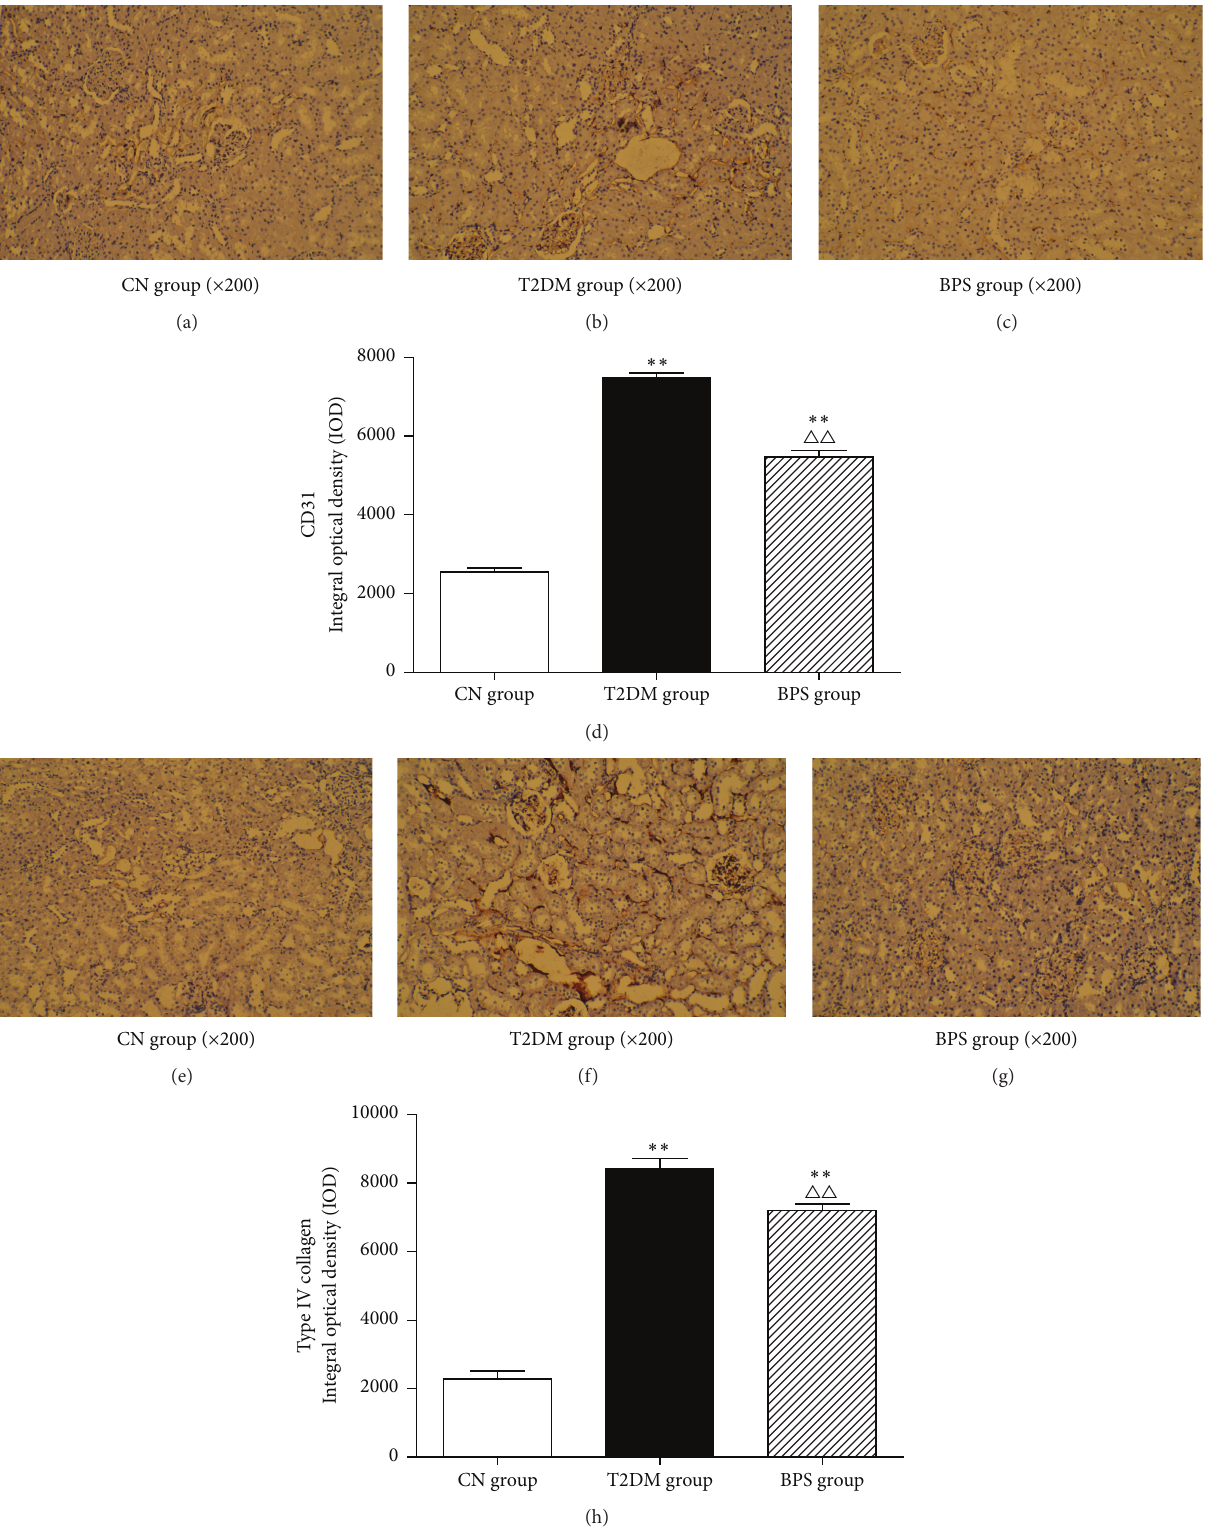
Figure 5: Immunohistochemical staining of CD31 (a, b, c) and collagen type IV (e, f, g) in Kidney tissues of CN group rats, T2DM group rats, and BPS group rats. As bar graph, data are mean ± SD of 6 rats. ∗ 𝑃 < 0.05 and ∗∗ 𝑃 < 0.01 T2DM group and BPS group versus CN group rats and 󳵻 𝑃 < 0.05 and 󳵻󳵻 𝑃 < 0.01 BPS group versus T2DM